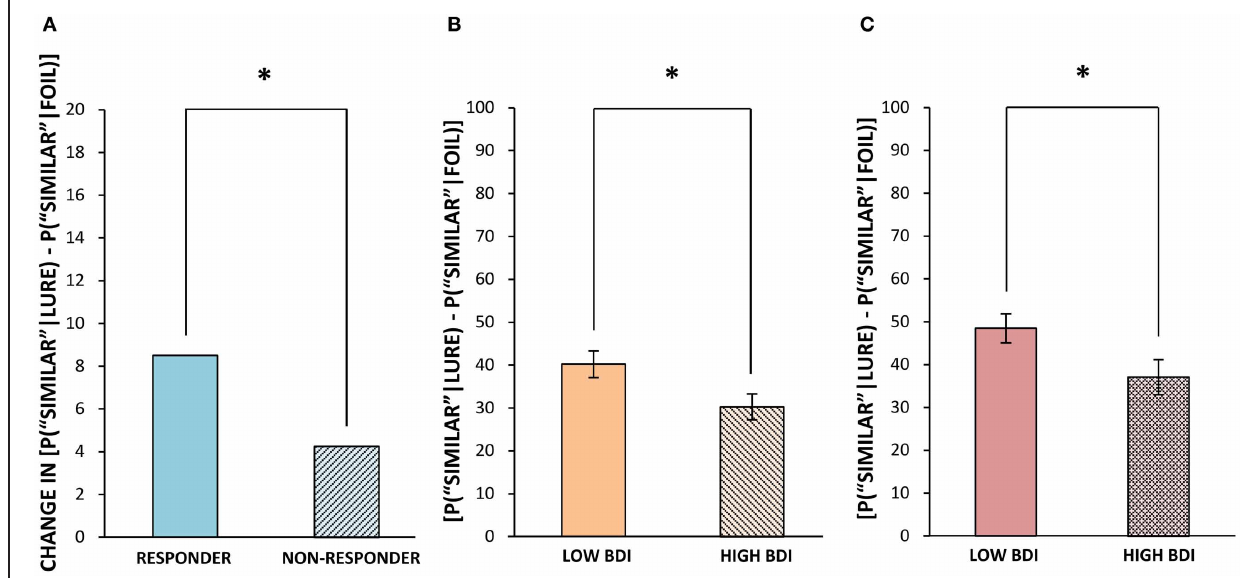
FIGURE 1 | Correct classification of similar lures pre- vs. post-exercise in Experiment 1 (A), and in those with below median and above median BDI scores in Experiment 2 (B,C). (A) Median change in % correct identification of lures as “similar” (bias corrected ranked difference scores) following exercise for responders